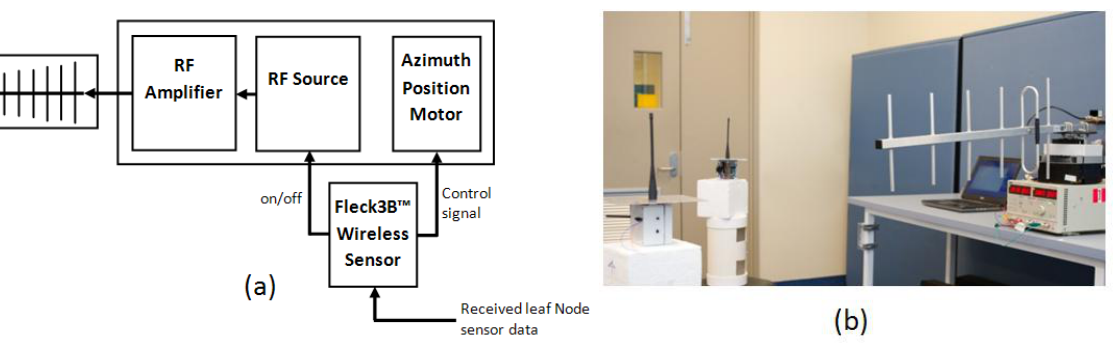
Figure 3. The base node: ( a ) power transmitter circuit and ( b ) the experimental setup showing the base node, the transmitting antenna, the rotator, and two leaf